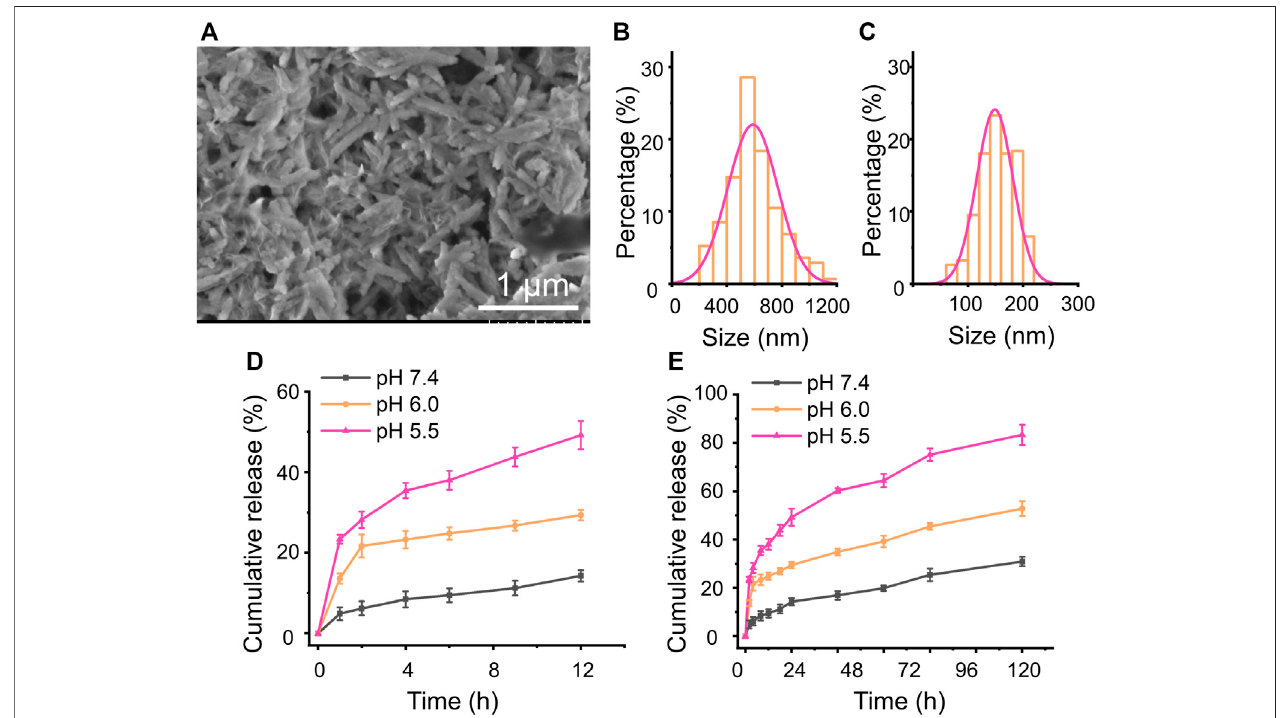
FIGURE 3 | (A) SEM images of the MC NRs. (B) length and (C) width statistical chart of the MC NRs. In vitro MTO cumulative release from the MC NRs in pH 7.4 and 6.0 and pH 5.5 PBS for (D) 12 h and (E) 72